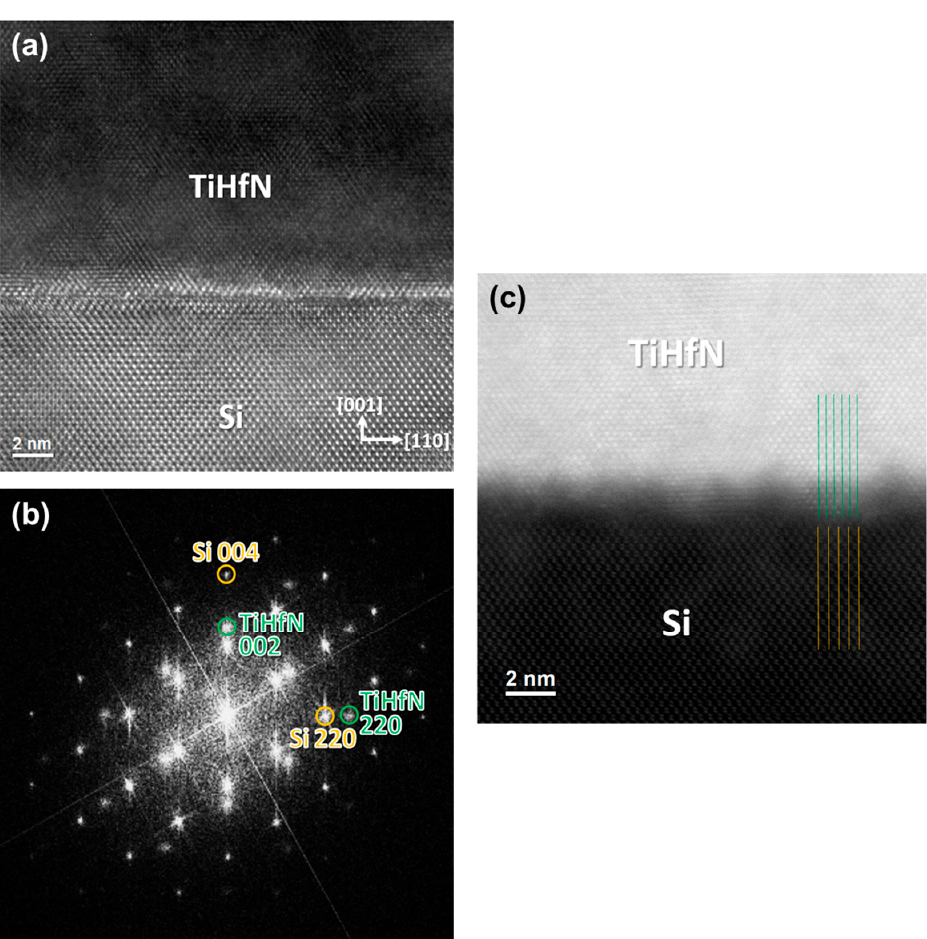
Figure 7. Cross-sectional S/TEM images of the as-deposited TiHfN/Si interface taken along the [110] zone axis. ( a ) HRTEM image, ( b ) the FFT pattern of ( a ), and ( c ) the STEM image in Z-contrast. The out-of-plane ( a ⊥ ) and in-plane ( a || ) lattice parameters of the TiHfN films can be deduced from X-ray reciprocal space mapping (RSM) results (not shown). For the as-deposited TiHfN, a ⊥ was 4.368 ± 0.002 Å and a || was 4.374 ± 0.002 Å. After plasma annealing, the a ⊥ and a || values were 4.360 ± 0.002 Å and 4.368 ± 0.002 Å, respectively. For a cubic structure, the relaxed lattice parameter, a 0 , can be determined from Equation (1):